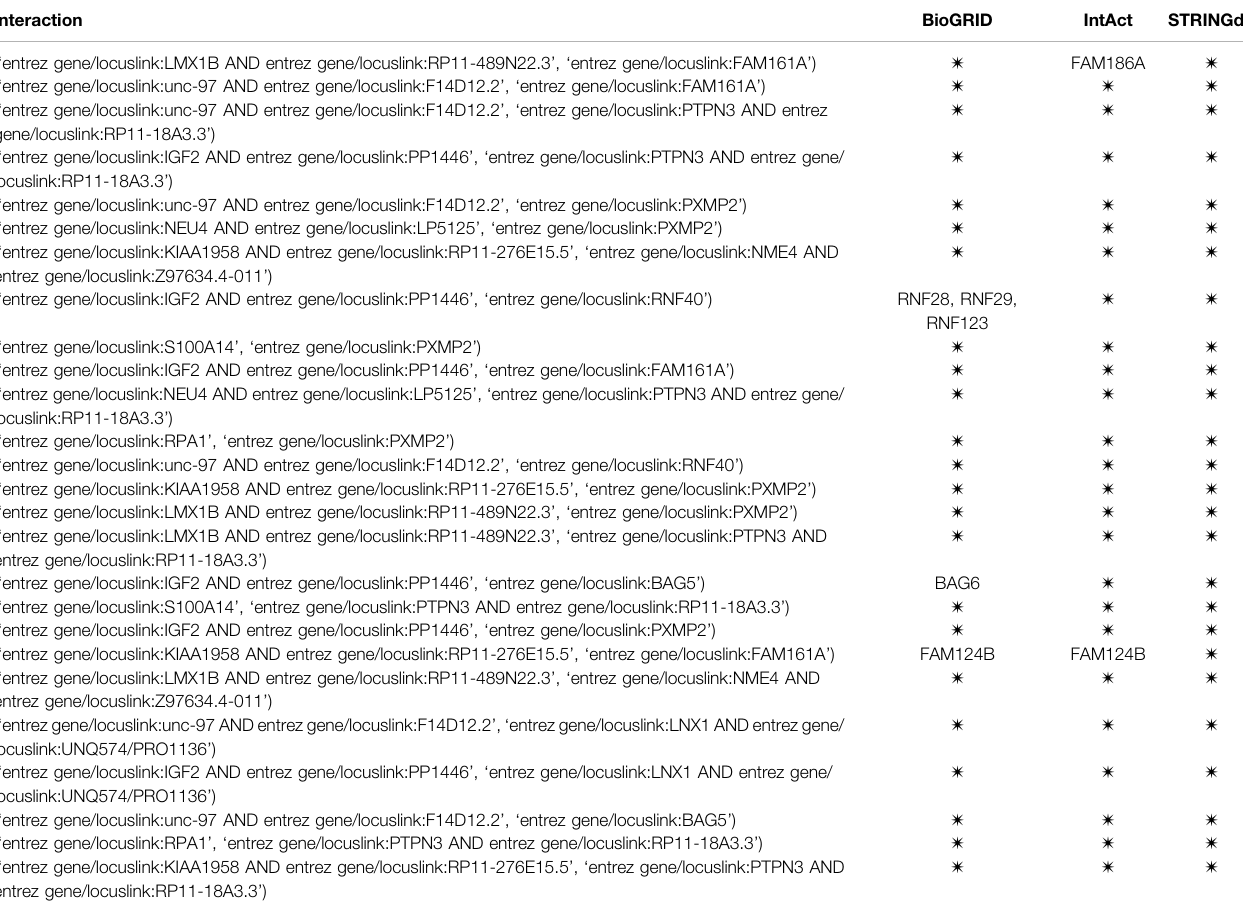
TABLE 2 | Assessment of false-positive interactions. Each of the 25 interactions was manually assessed in the three stated databases for possible presence. Interaction